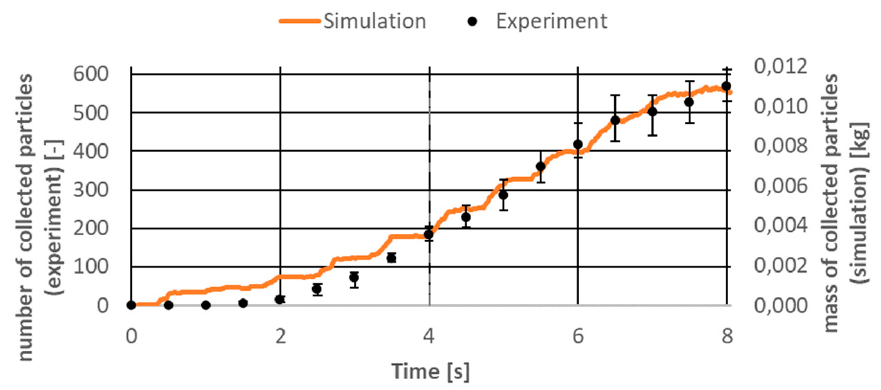
Figure 13. Simulation and experimental results comparison.